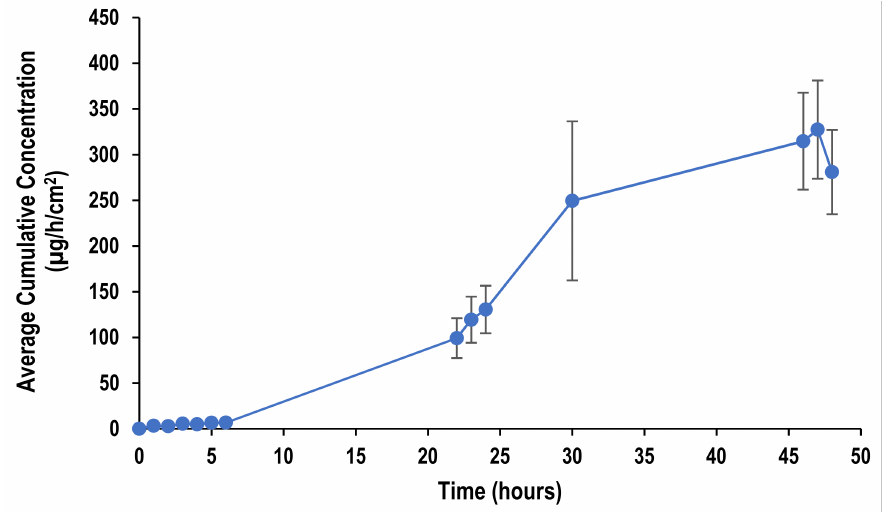
Figure 11. Permeation profile of lidocaine nanoemulsion through pig ear skin over 48